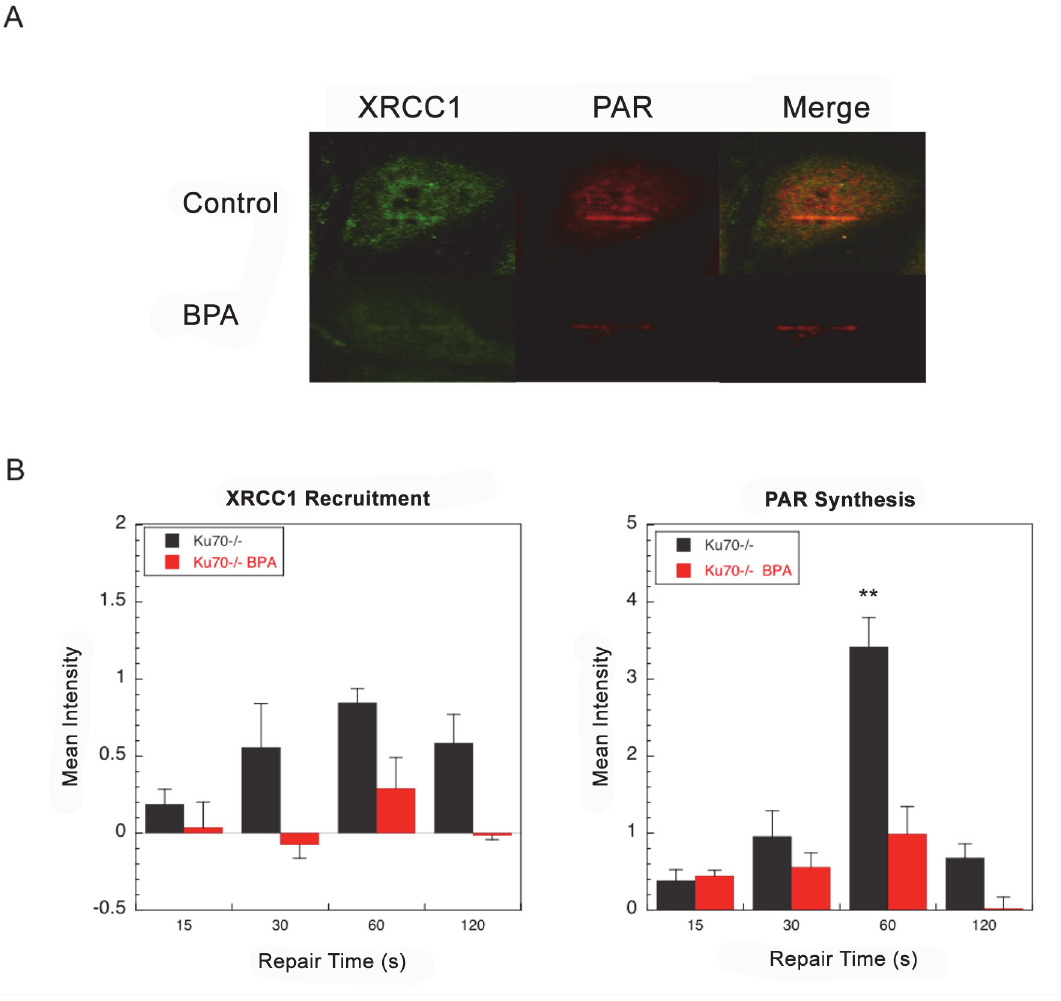
Fig 5. Recruitment of BER factors to sites of laser-induced DNA damage in Ku70-deficient cells. Recruitment of XRCC1 and PAR polymer accumulation were measured at sites of DNA damage in Ku70-deficient cells as described in Materials and Methods. (A) Images obtained one minute after irradiation of Ku70-deficient cells with and without 150 μ M BPA. (B) Time courses of XRCC1 recruitment and PAR synthesis to the site of damage in Ku70- deficient cells with the repair times specified. Images are representative; at least 15 cells were measured for every time point and each bar represents mean ± SEM of three independent experiments ( * p < 0.05 vs. control). Scale bars are 20 μ